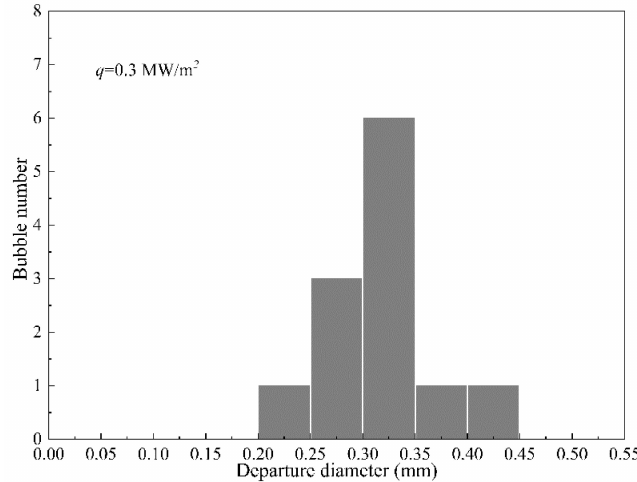
Figure 11. Bubble departure diameter at heat flux of 0.3 MW/m 2 , inlet velocity of 0.4 m/s, and inlet subcooling of 3 K.